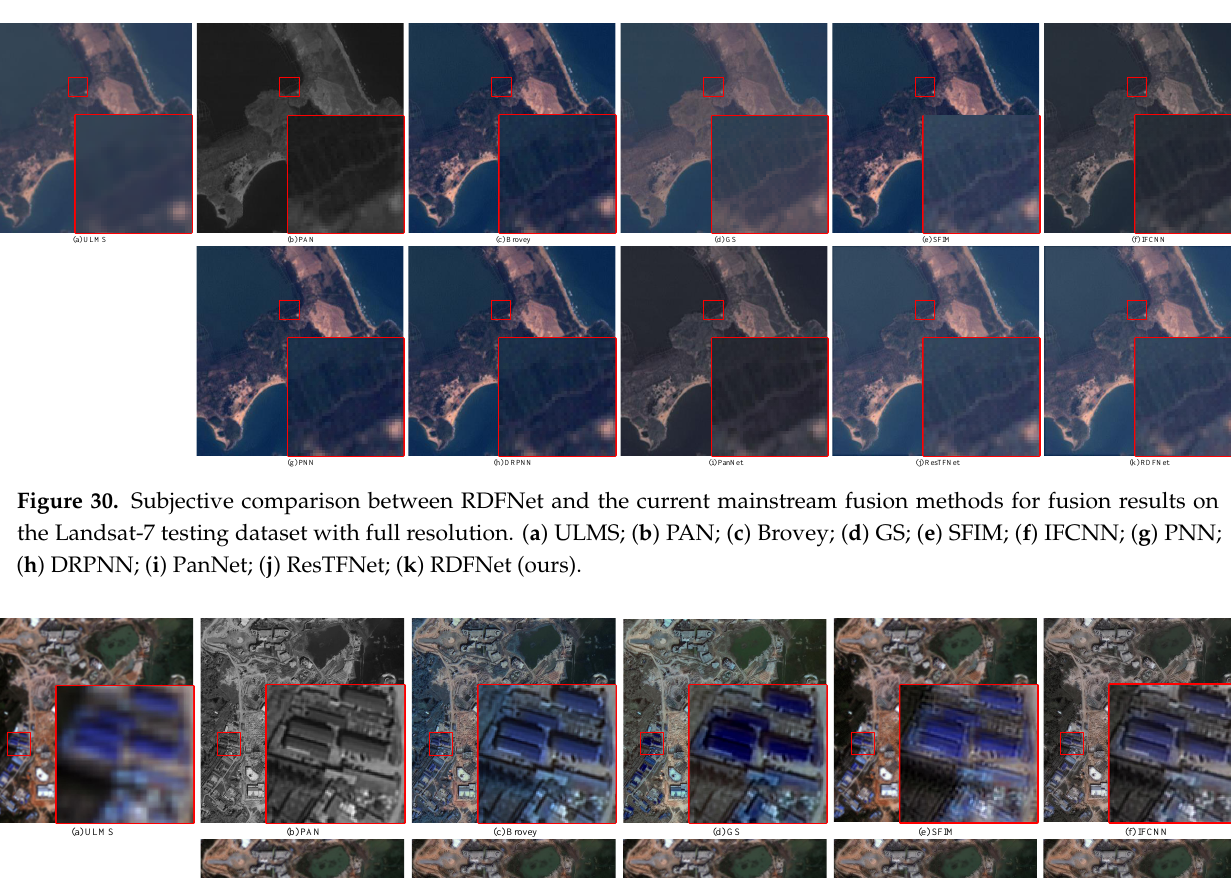
Figure 29. Subjective comparison between RDFNet and the current mainstream fusion methods for fusion results on the QuickBird testing dataset with full resolution. ( a ) ULMS; ( b ) PAN; ( c ) Brovey; ( d ) GS; ( e ) SFIM; ( f ) IFCNN; ( g ) PNN; ( h ) DRPNN; ( i ) PanNet; ( j ) ResTFNet; ( k ) RDFNet (ours).